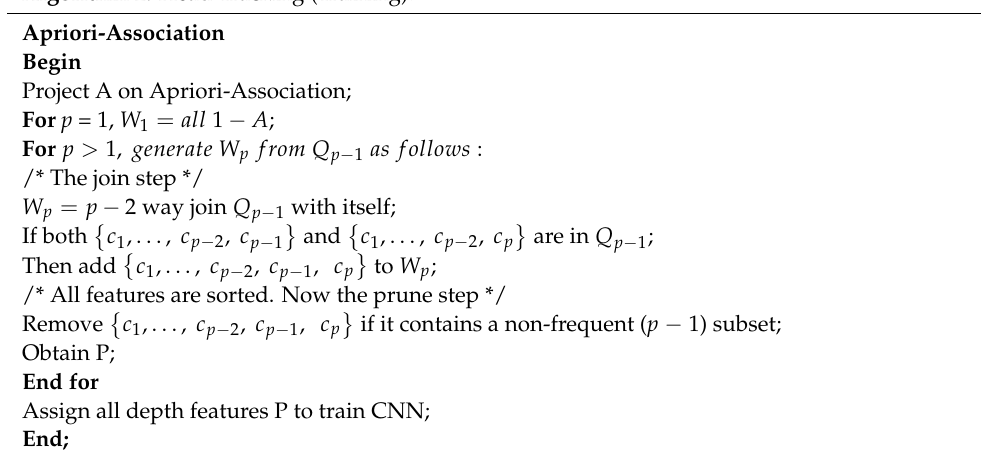
Figure 8. Illustration of the Apriori-Association graph of the accuracy of all three datasets across three feature extraction techniques. Algorithm 2: Head Tracking